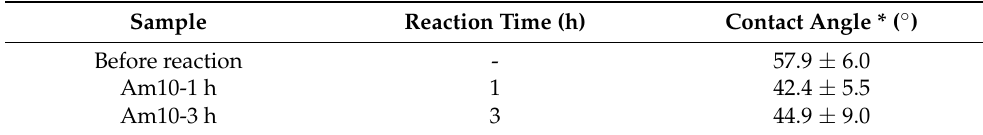
Table 3. Contact angle measurements.